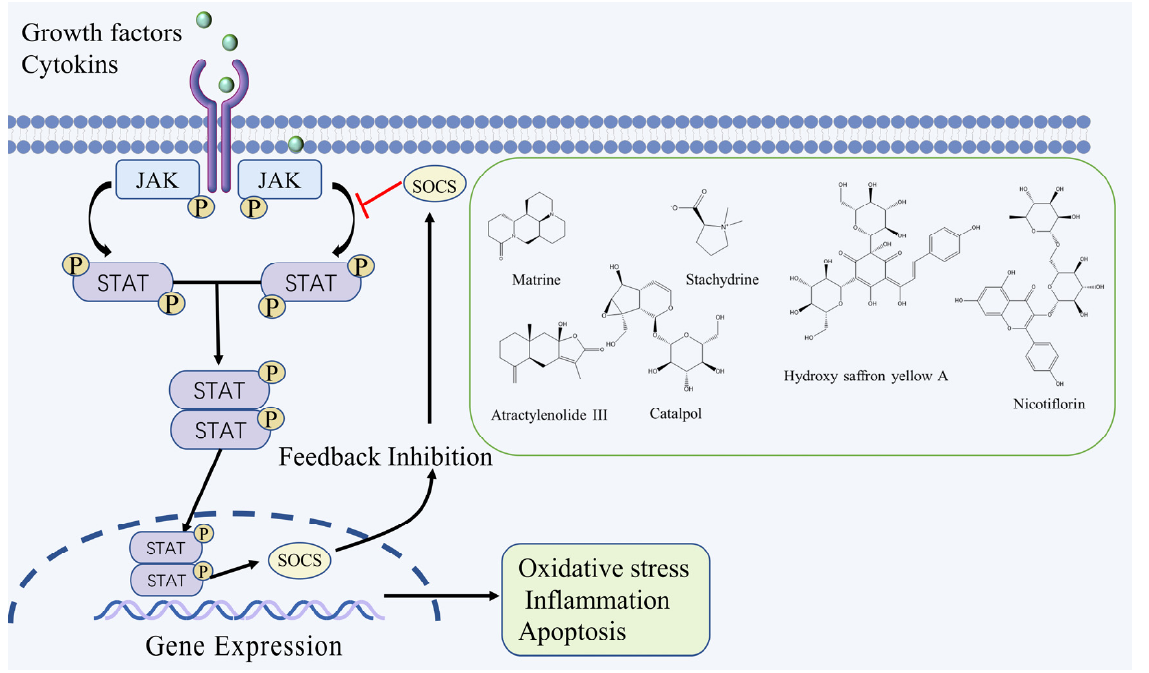
Figure 1. JAK/STAT signaling pathway and the chemical structure of natural compounds.